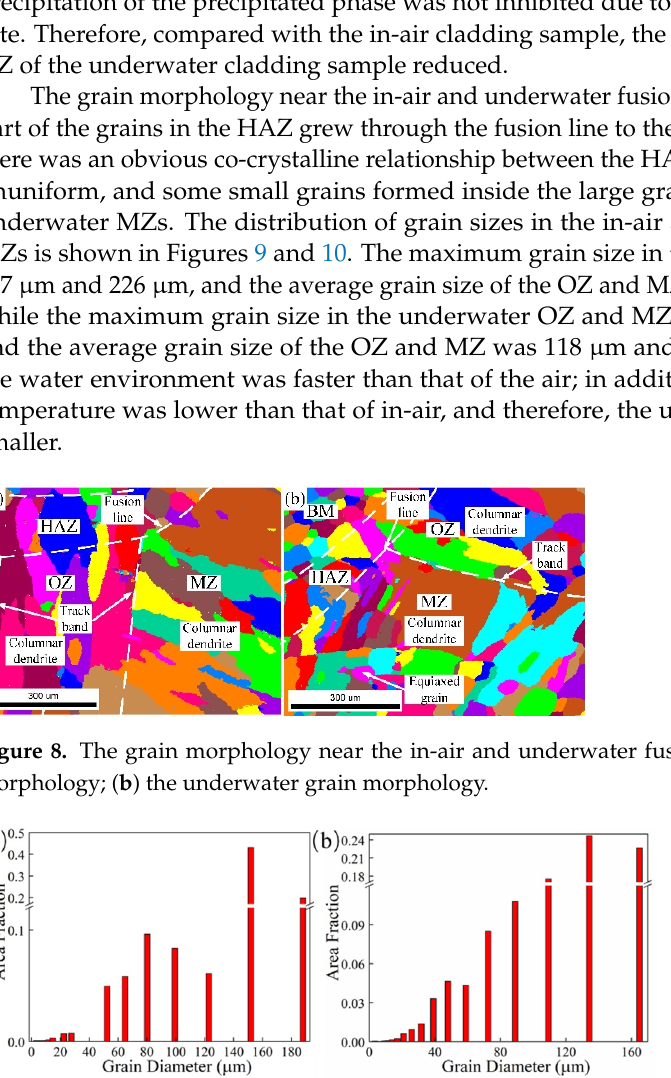
Figure 7. The microstructure in distinctive zones of underwater cladding layer: ( a ) the microstruc- ture near fusion line; ( b ) the local amplification of CZ; ( c ) OZ; ( d ) the local amplification of OZ.